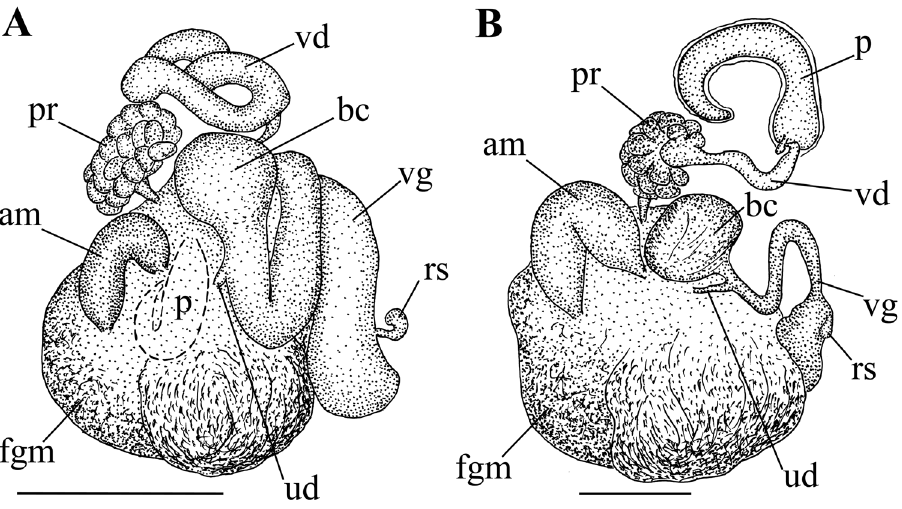
Figure 3. Reproductive systems: A Dendronotus arcticus sp. n., holotype ZMMU Op-561 B Dendrono- tus robilliardi sp. n., paratype ZMMU Op-567. Abbreviations: am ampulla; bc bursa; fgm female gland mass; pr prostate; p penis; rs receptaculum semenis; u uterine duct; vd vas deferens; vg vagina. Drawings by Tatiana Korshunova. Scale bars 1